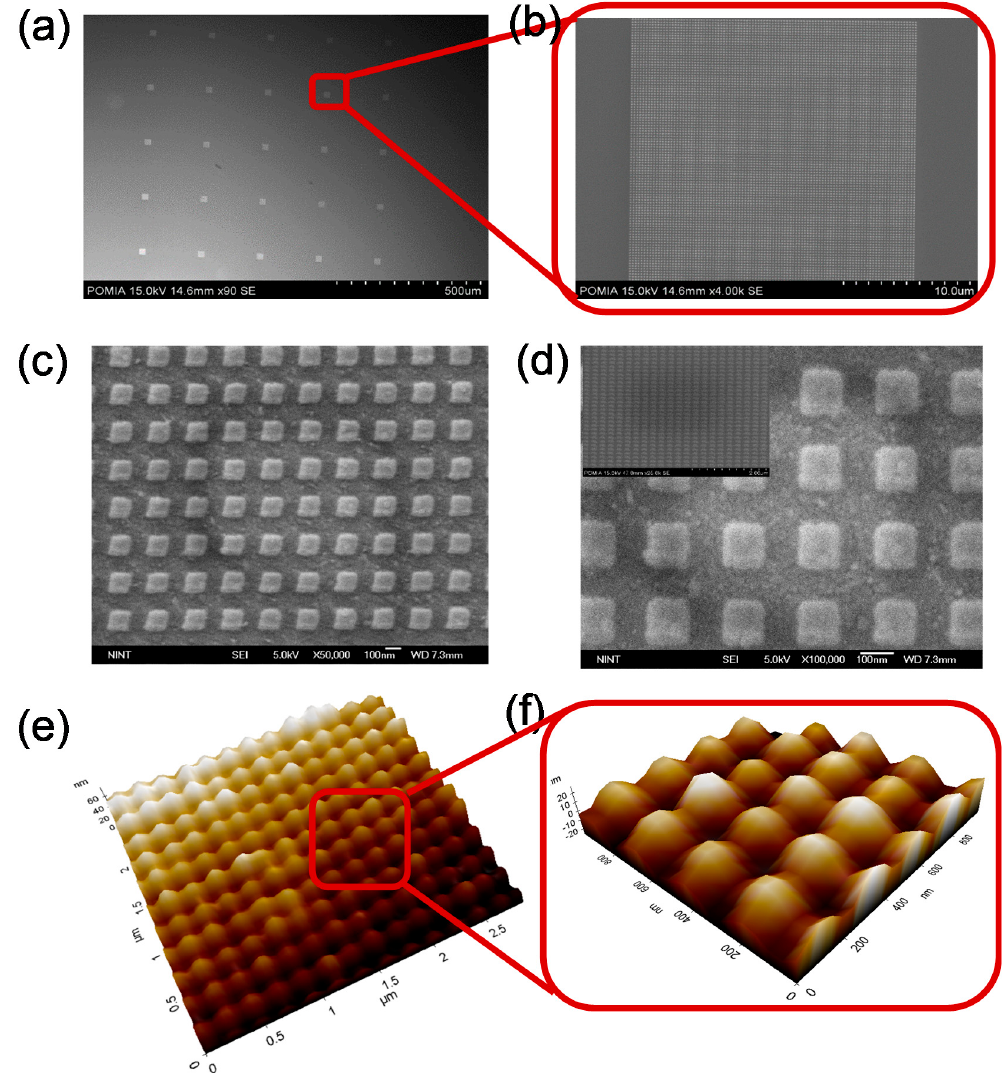
Figure 2. ( a ) Scanning electron microscope (SEM) images of the fabricated resistive switching memory (ReRAM) and metamaterial perfect absorber (MPA) devices with 5 × 5 arrays of nanostructures; ( b ) A magnified image of one square patch with dimensions of 100 µ m; ( c ) 120 × 120 nm patterned square-shaped nanostructures; and ( d ) 20 ◦ tilted square patterns; inset: a perspective view of the ReRAM. ( e ) AFM image of the patterned Ag top electrode and ( f ) the magnified AFM image.